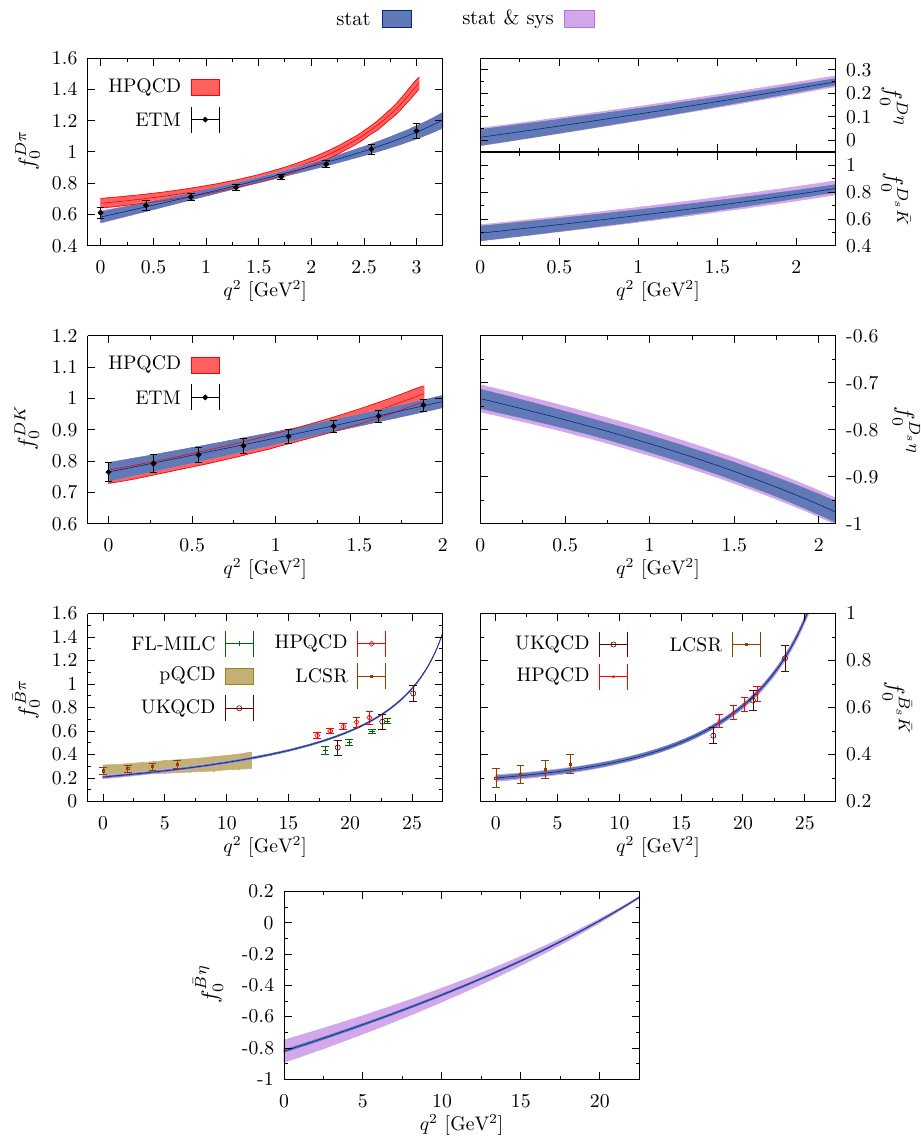
Fig. 9 Scalar form factors from the D (cid:3) 3 , ¯ B (cid:3) 3 and ( ¯ B s ) (cid:3) 3 combined fit oration are also displayed. Differences between ETM and HPQCD sets of D → π and D → K form factors are clearlyvisiblein the vicinityof (see Table 4 for details). The three bottom panels are similar to those q 2 max , in particular for the D → π case. Statistical (stat) and statistical depicted in Fig. 8, but computed from the results of the combined best- fit. The four panels in the first two rows show form factors for c → d , s plus systematic (stat & sys) 68%-confident level bands are also given semileptonic transitions. Only ETM results, corrected for some hyper- and are calculated as explained in Fig. 8. Finally, predictions for the D → η , D s → K and D s → η scalar form factors are also shown cubic (discretization) effects [21], have been considered in the fit of Table 4. For comparison, predictions from the HPQCD [16,17] Collab- relating β B and β B through Eq. (52) and minimizing χ 2 1 2